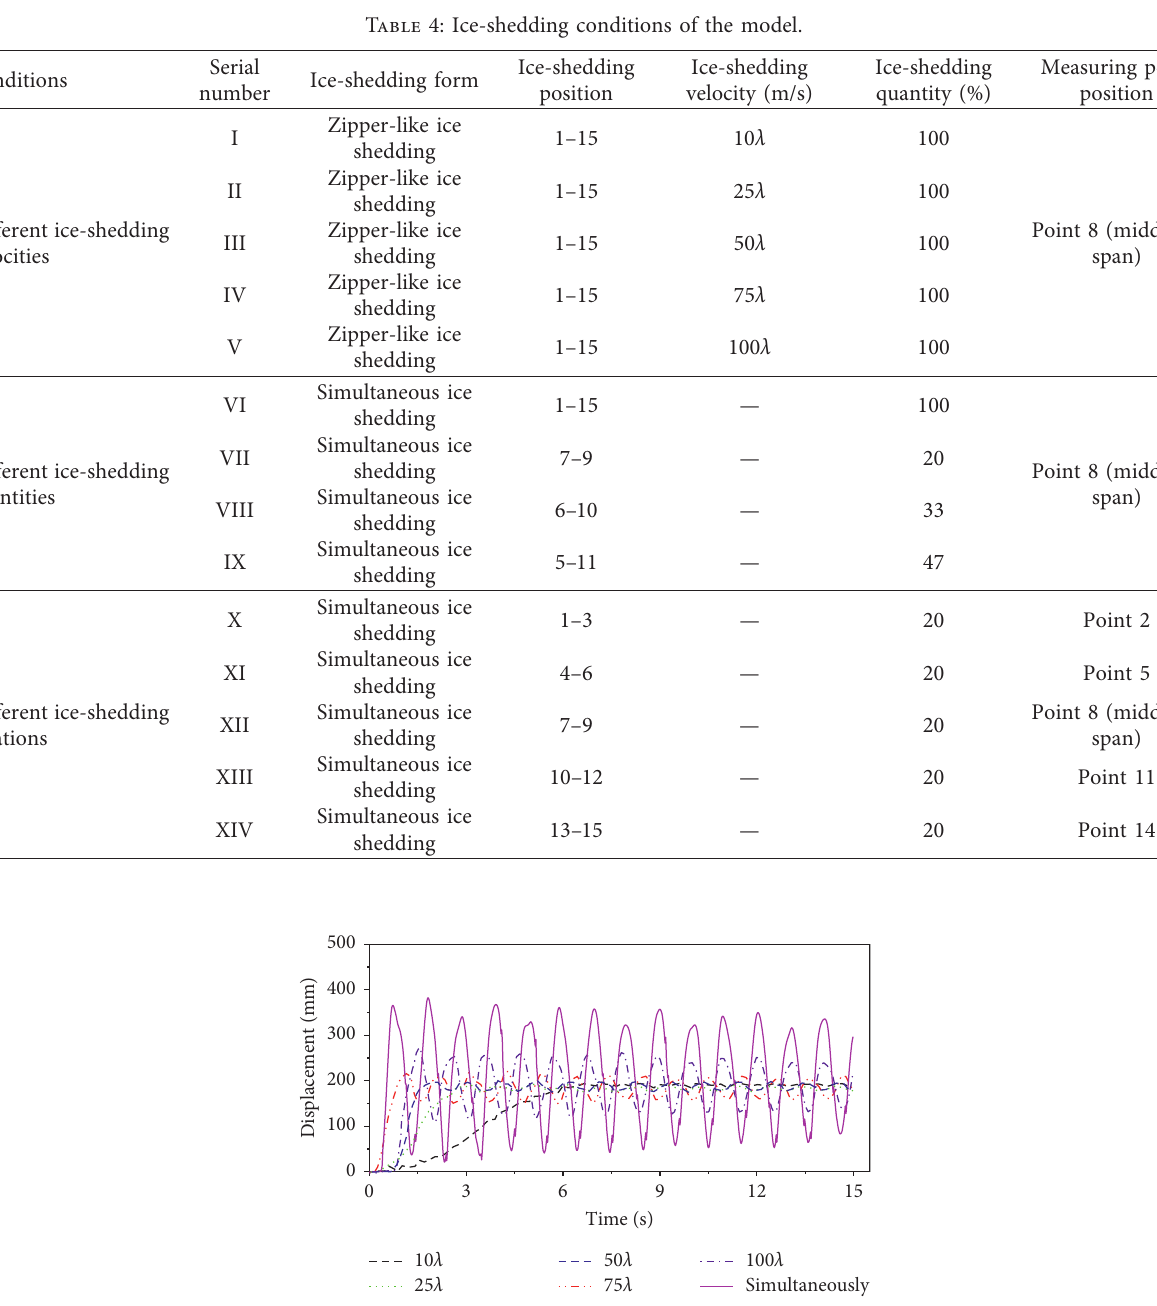
Figure 4: Displacement-time history curve of the midpoint of ice-shedding span under different ice-shedding velocities (I ∼